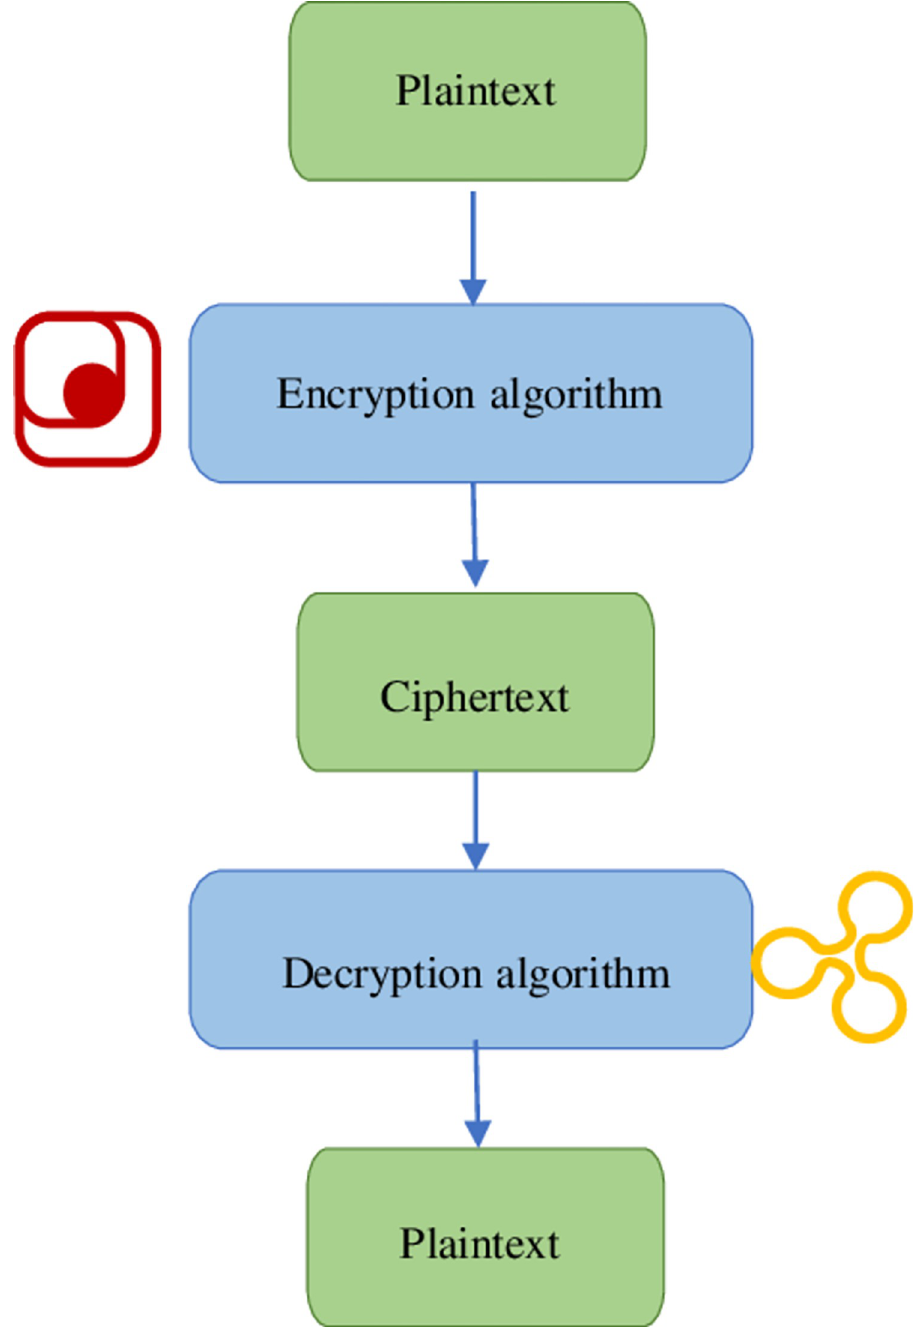
Fig 5. Schematic diagram of network data